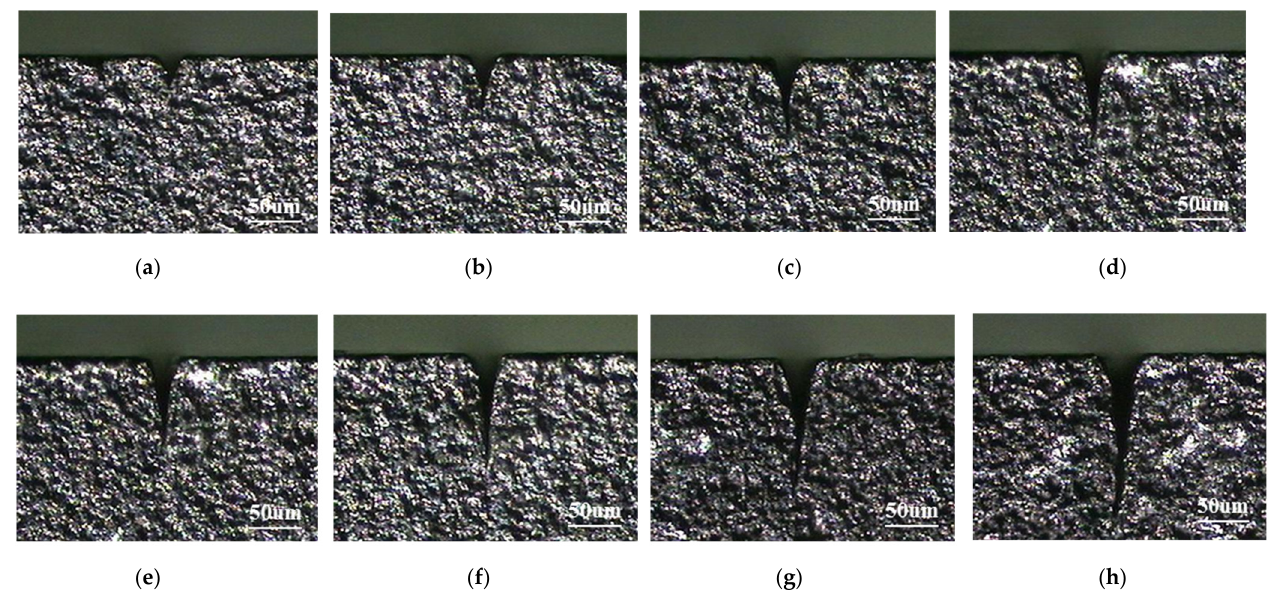
Figure 10. Effect of variation in pulse width on kerf depth in laser cutting of PCD workpiece. The fixed average power was 30 W, and the lowest pulse repetition rate for a specific kerf width was selected, as shown in Table 5. ( a ) Pulse width of 4 ns; ( b ) pulse width of 8 ns; ( c ) pulse width of 14 ns; ( d ) pulse width of 20 ns; ( e ) pulse width of 30 ns; ( f ) pulse width of 50 ns; ( g ) pulse width of 100 ns; ( h ) pulse width of 200 ns.